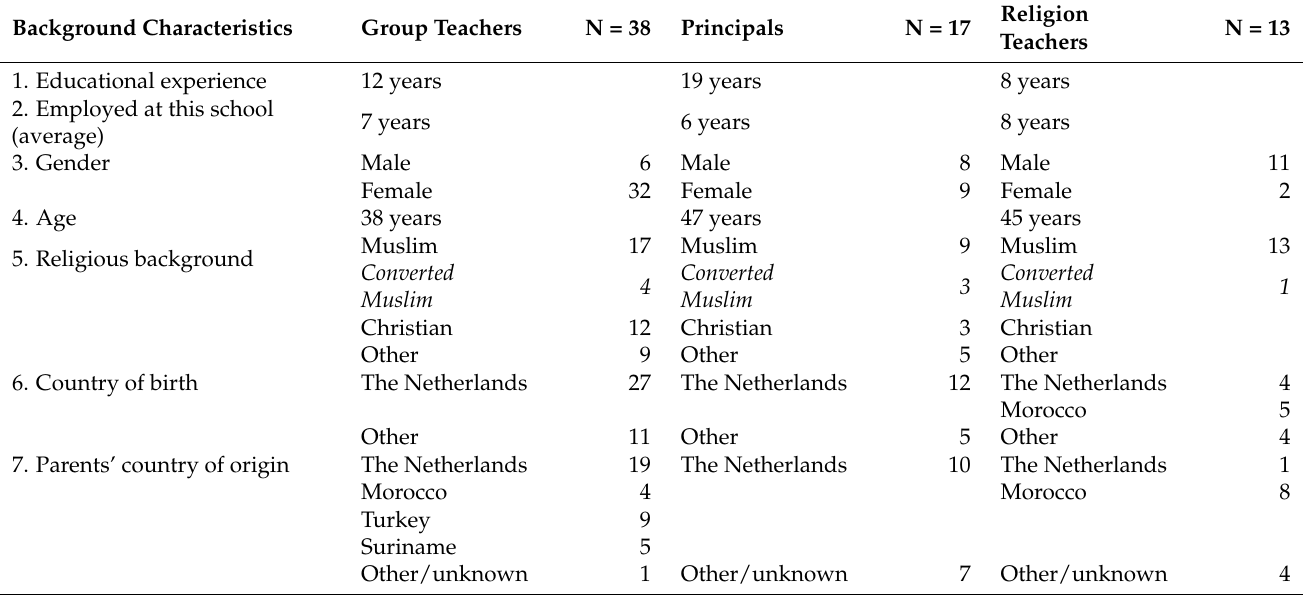
Table 2. Background data by function (group teachers, directors and religion